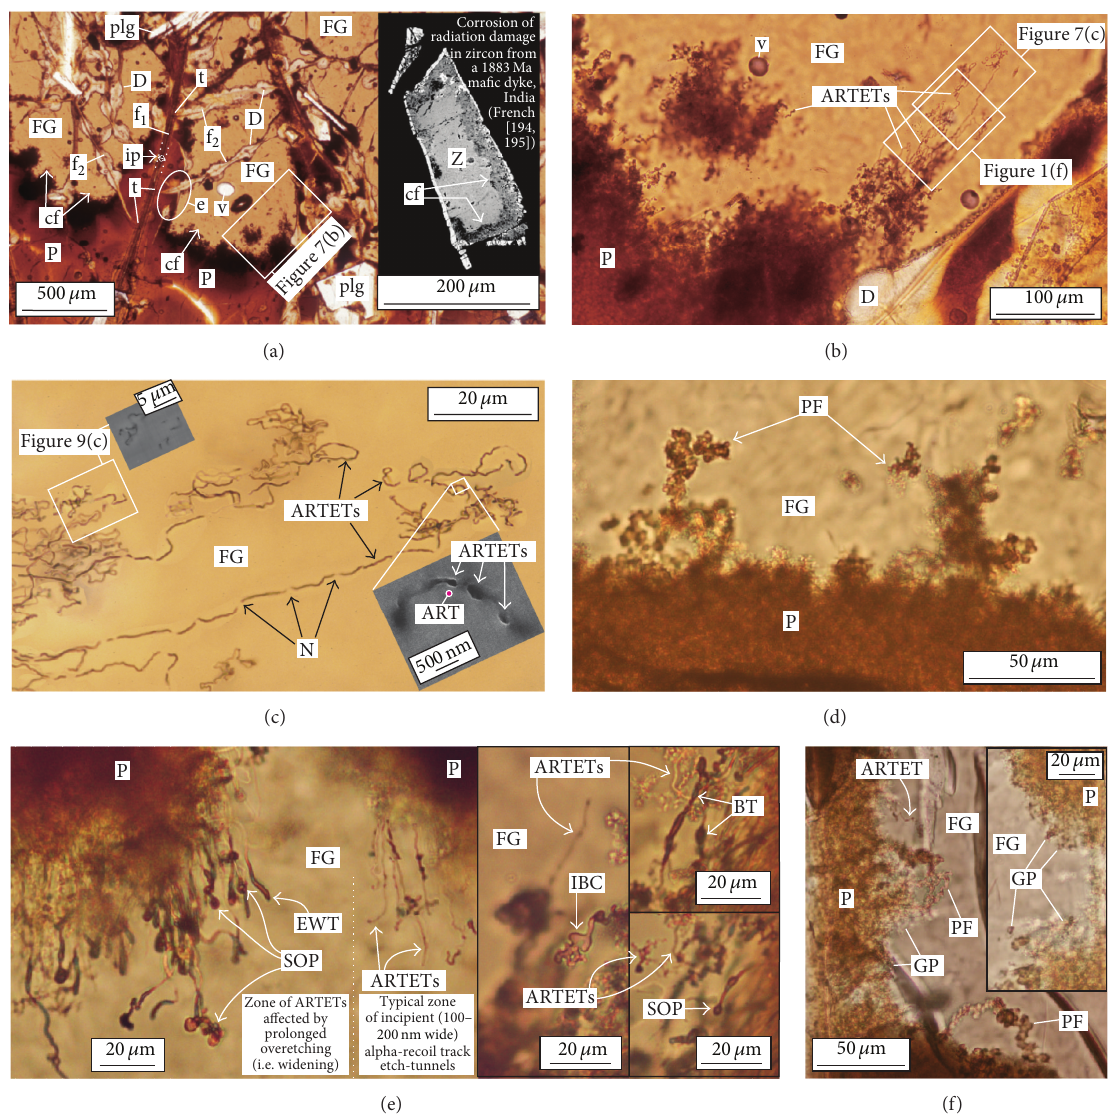
Figure 7: Diversity of abiotic corrosion microtextures in DSDP 418A basaltic glass linked with palagonitization (all thin section photomicrographs are taken in plane polarized light (uncrossed nicols); (a–e): sample DSDP-418A-75-3[120–123] ; (f): sample